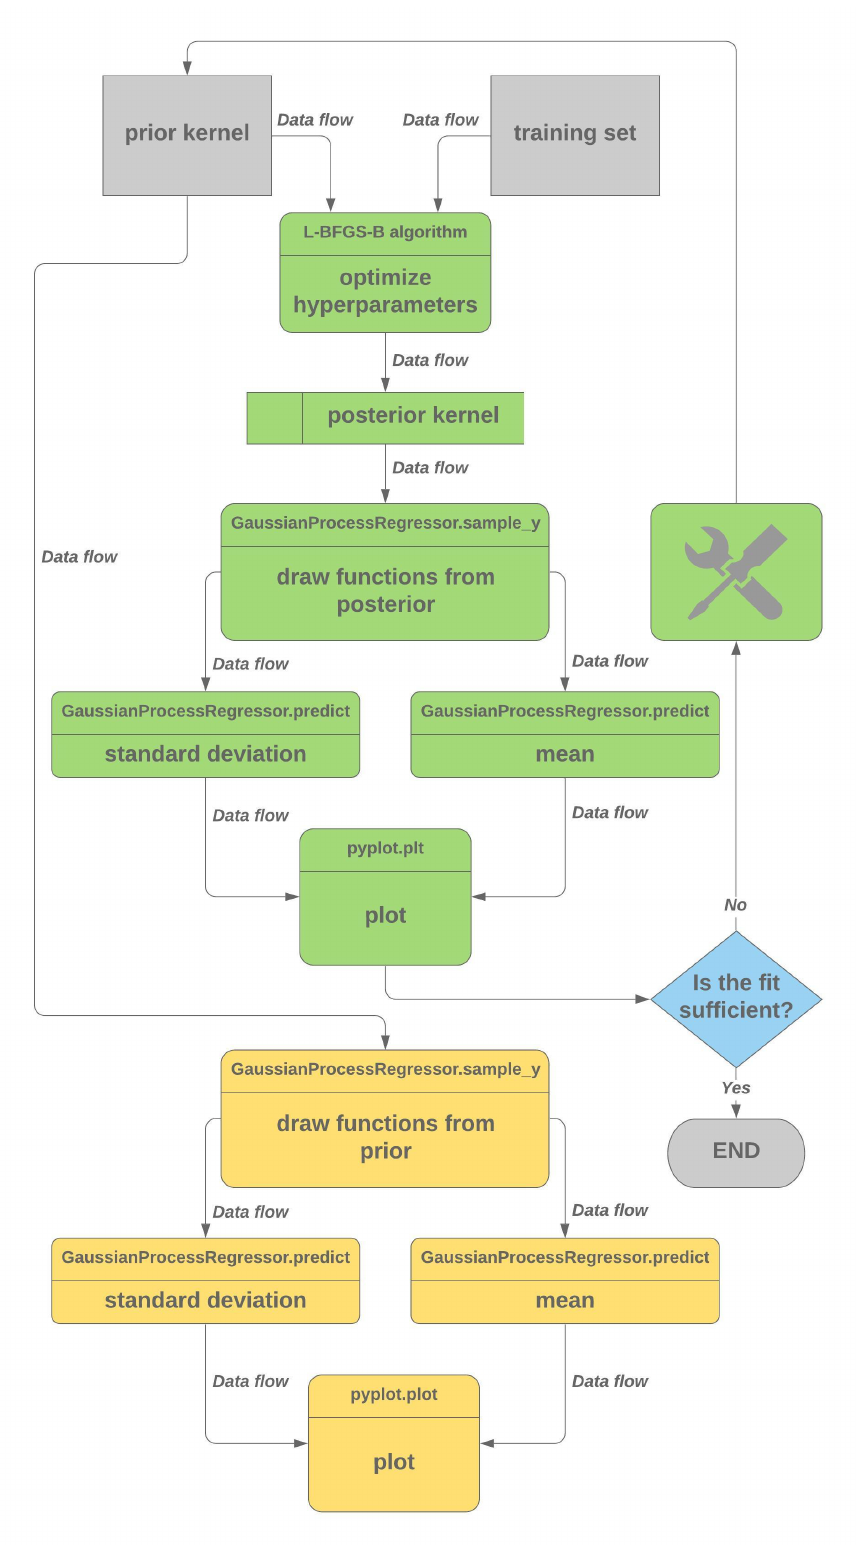
Figure 7. Flow diagram for the implementation of Gaussian process regression that was used for this paper. Samples are drawn from the posterior after the kernel hyperparameters have been optimized based on the training